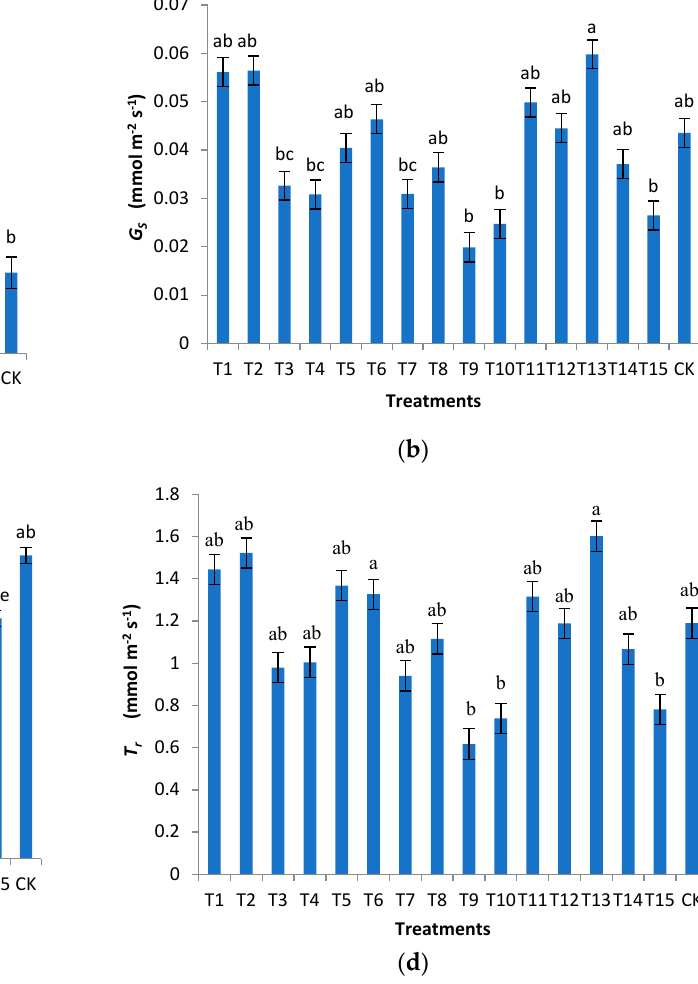
Figure 4. Photosynthetic parameters of H. chrysanthus seedlings with different mixed substrates: ( a ) net photosynthetic rate ( P n , μ mol m − 2 s − 1 ), ( b ) stomatal conductance ( G s , mmol m − 2 s − 1 ), ( c ) intercellular carbon dioxide concentration ( C i , μ mol m − 2 s − 1 ), and ( d ) transpiration rate ( T r , μ mol m − 2 s − 1 ). Significant differences between treatments are indicated by different lowercase letters (Tukey’s HSD test; p < 0.05; mean ± SE).